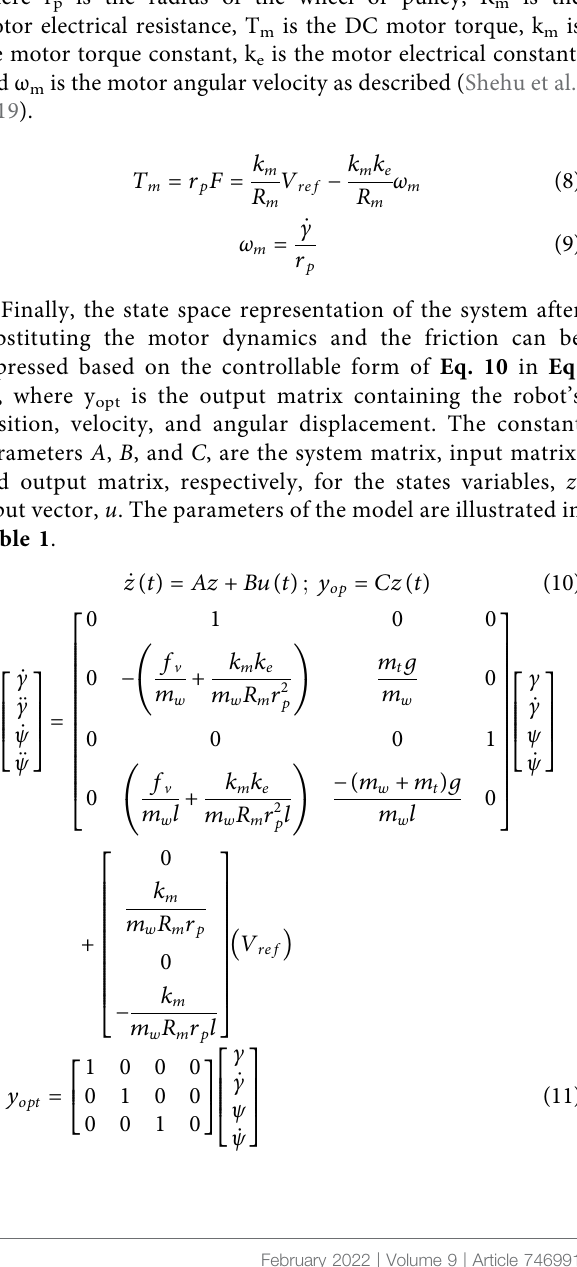
FIGURE 3 | The simpli fi ed schematics of the robot represented as a single roller carrying a